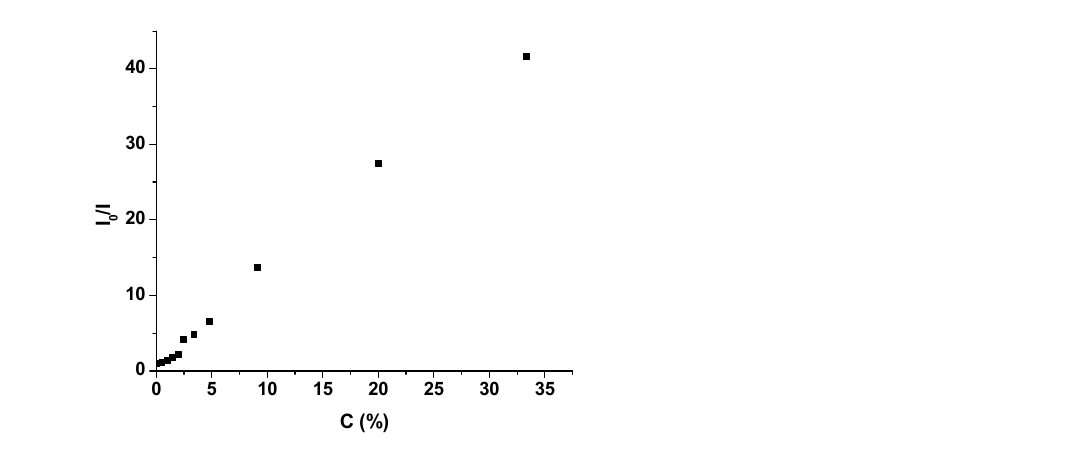
Figure 10. Stern–Volmer curves for fluorescence quenching of 7 in dioxane adding different amounts of water.